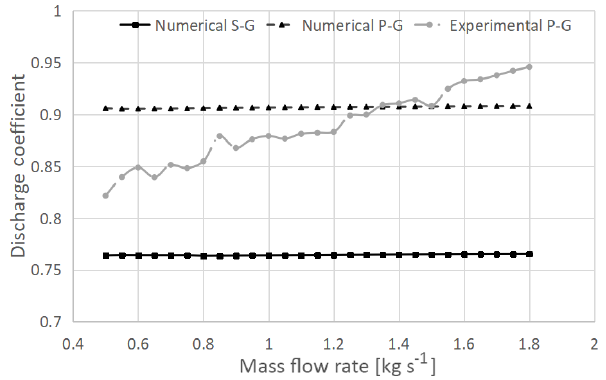
Figure 26. Least squares fit of CFD data, proposed